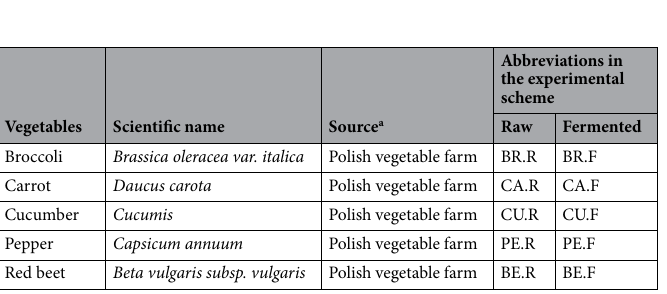
Table 2. Scientific and common names of experimental vegetables and abbreviations used in the experimental scheme. a According to the information from the seller.